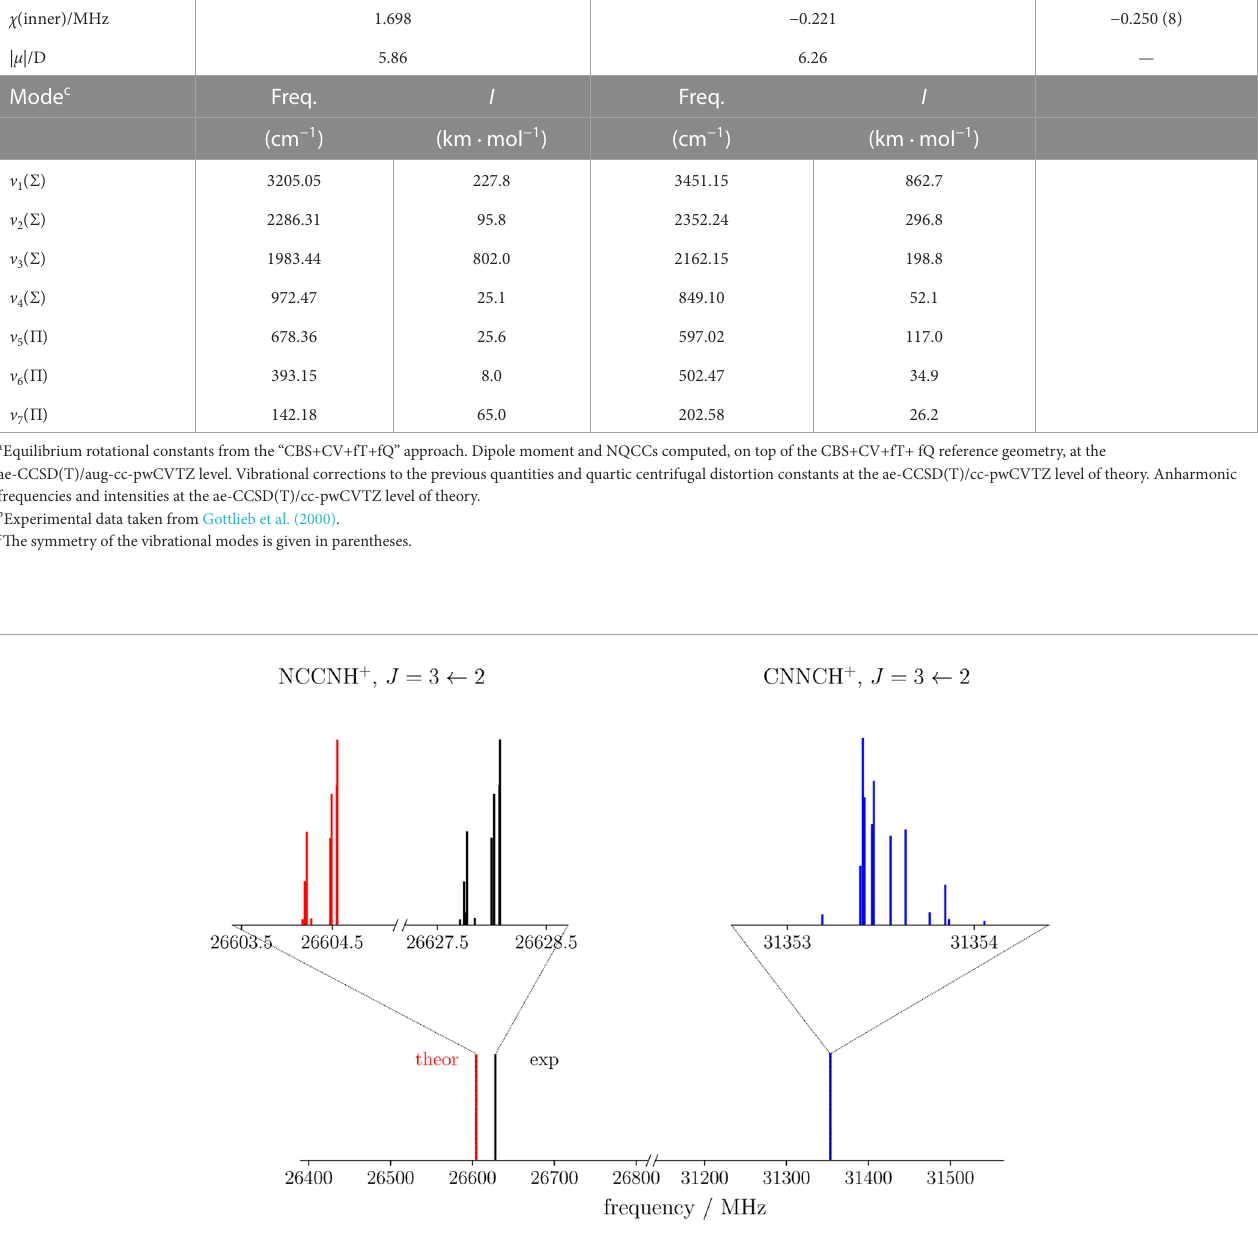
FIGURE 4 Theoretical (red) and experimental (black) J = 3 ← 2 transition of NCCNH + compared with the simulation of the same transition of CNNCH + (blue). The insets show in detail the corresponding hyperfine structures.